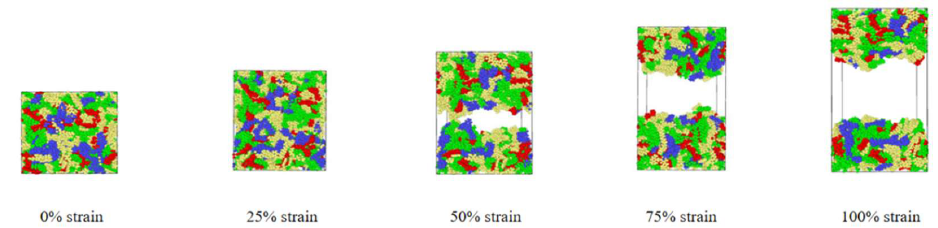
Figure 4. Stretching process under 25 °C, 10 m/s.